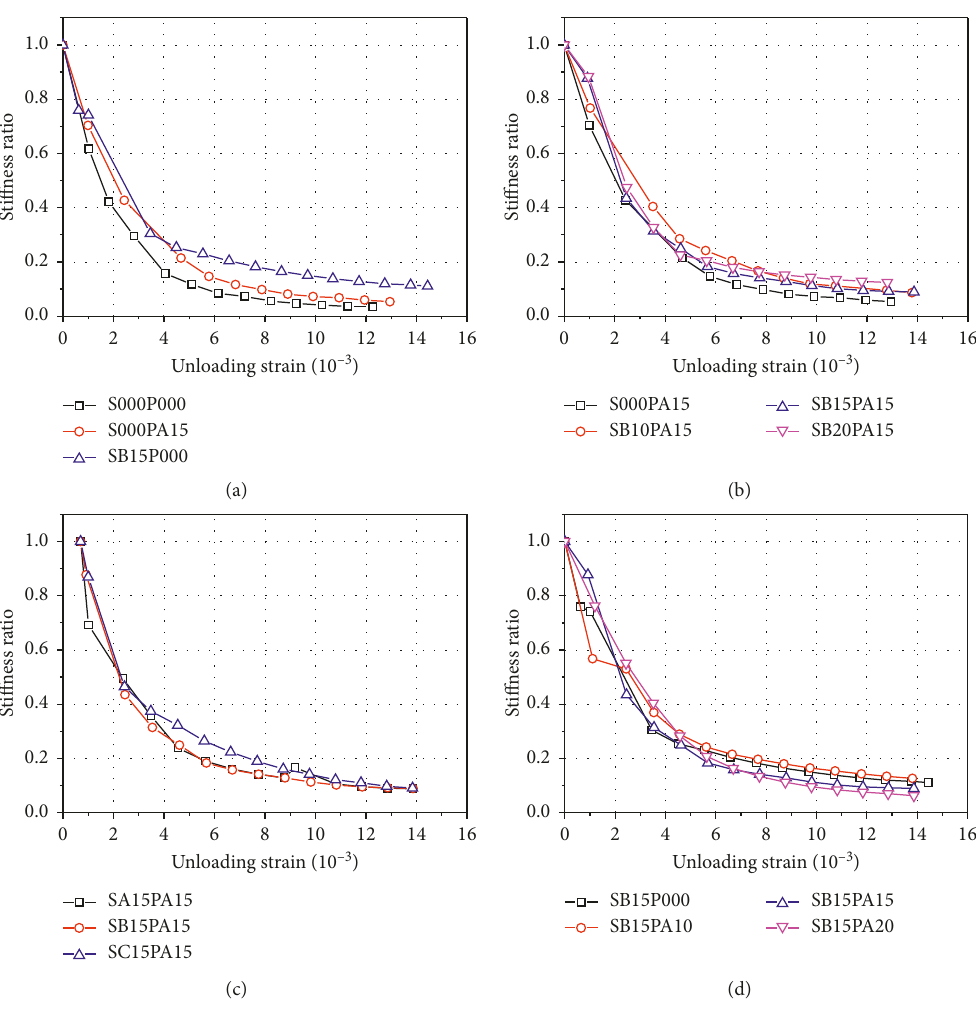
Figure 8: Unloading stiffness degradation of HFRC under cyclic compression: (a) effect of fiber type; (b) effect of volume fraction of SF; (c) effect of aspect ratio of SF; (d) effect of volume fraction of